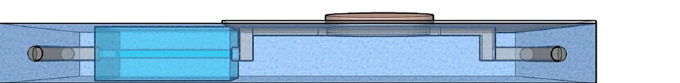
Figure 4. Side view of the microfluidic chip.